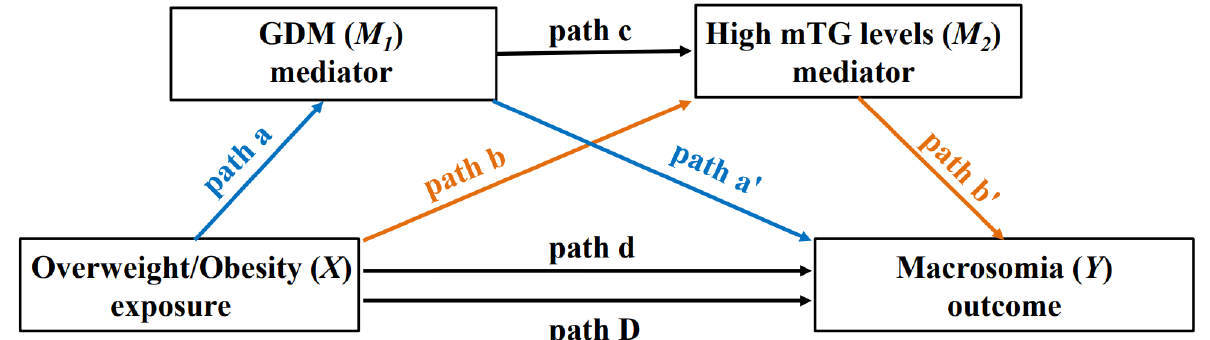
Figure 1. The illustration of the total effect (path D), indirect effect (path a, a ′ , b, b ′ and c) and direct effect (path d) on the relationship of the exposure ( X ) with outcome ( Y ) via the mediator ( M 1 and M 2 ). Abbreviations: GDM, gestational diabetes mellitus; mTG, maternal triglyceride.